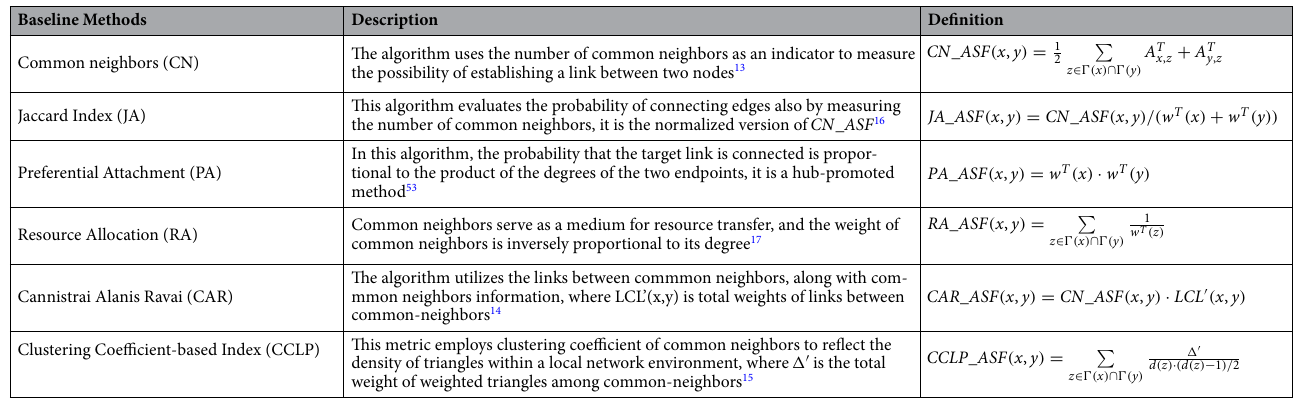
Table 3. Baseline link prediction methods for temporal networks.